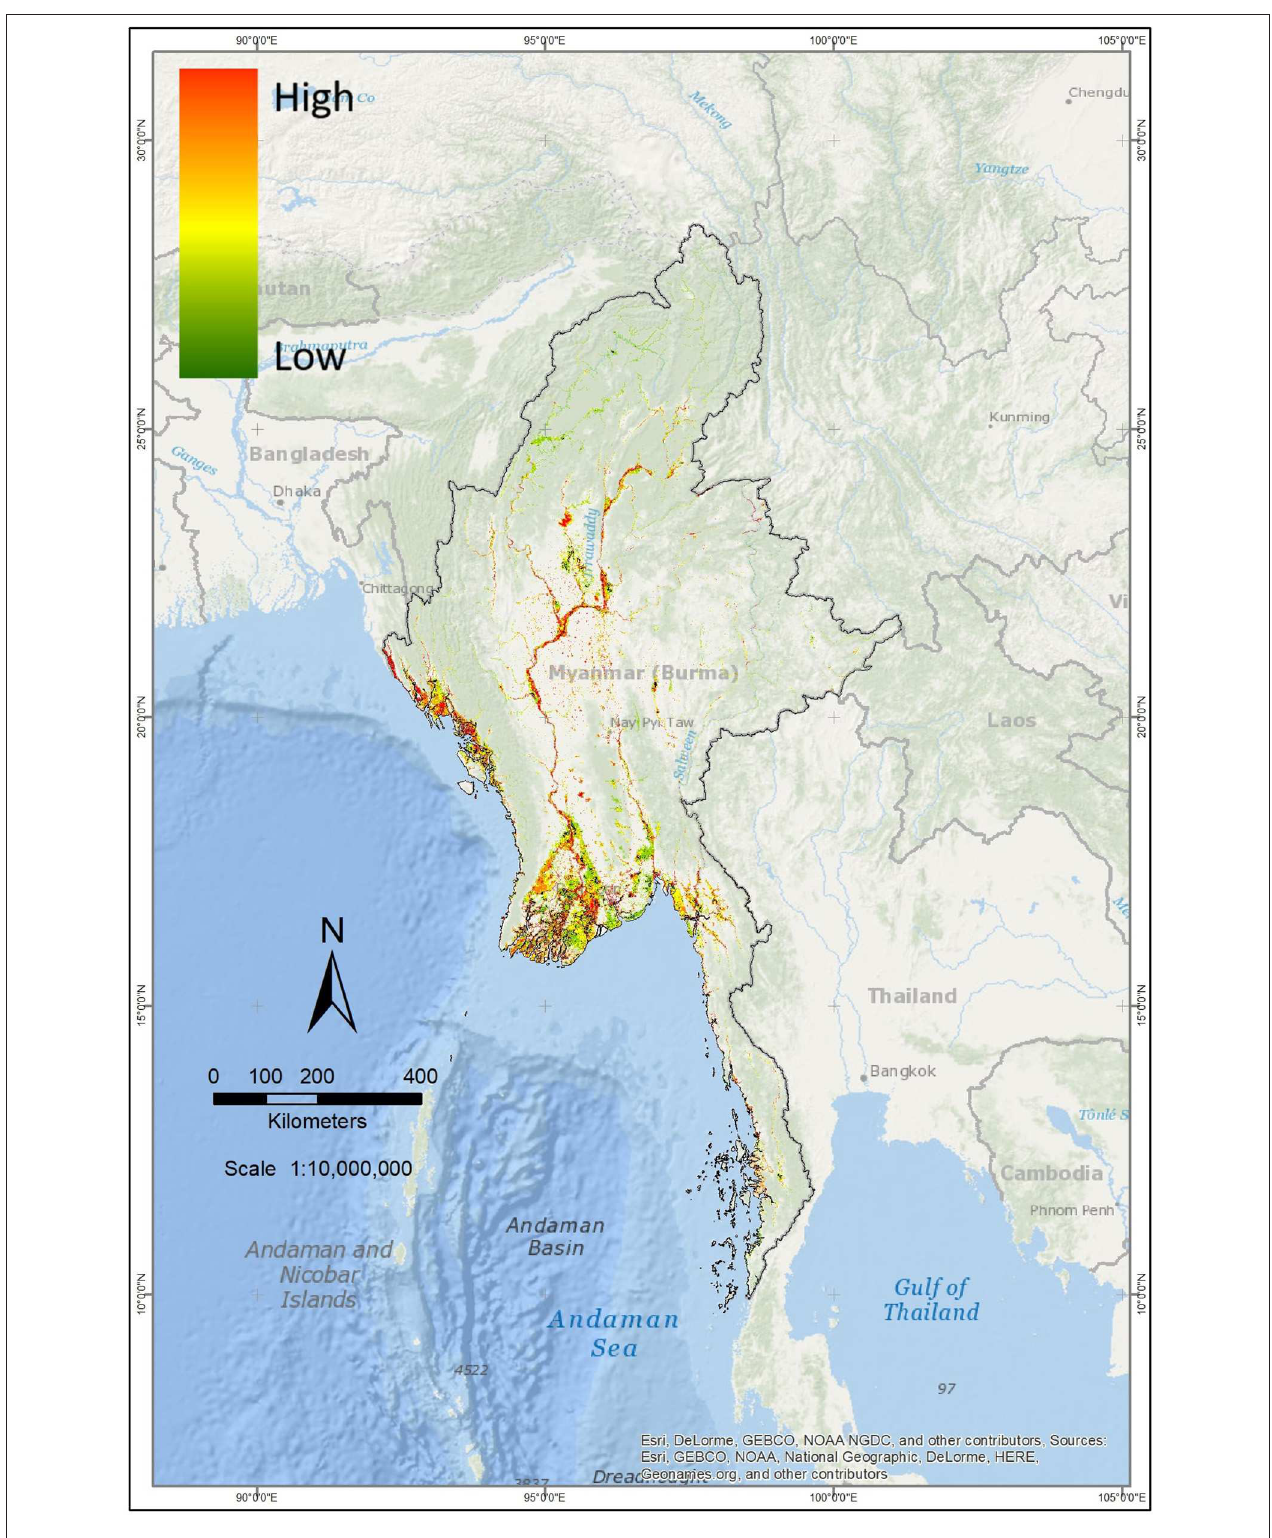
FIGURE 8 | Flood risk at the country-wide scale for